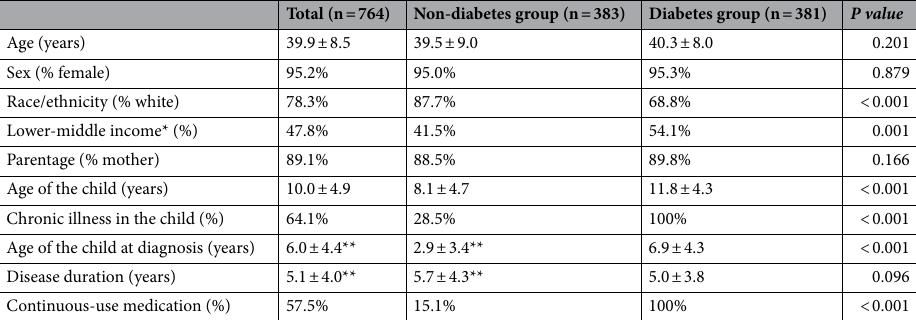
Table 1. Demographics and clinical characteristics of study participants. Data are mean ± standard deviation or %. α ≤ 0.05 indicates significant difference. *Family that receives a total of less than 2564 reais per month, as defined by the Strategic Affairs Secretariat (SAE) of Brazil in 2012, equivalent to 495.8 dollars or 430 euros. **Data included only participants in the non-diabetes group who have some chronic